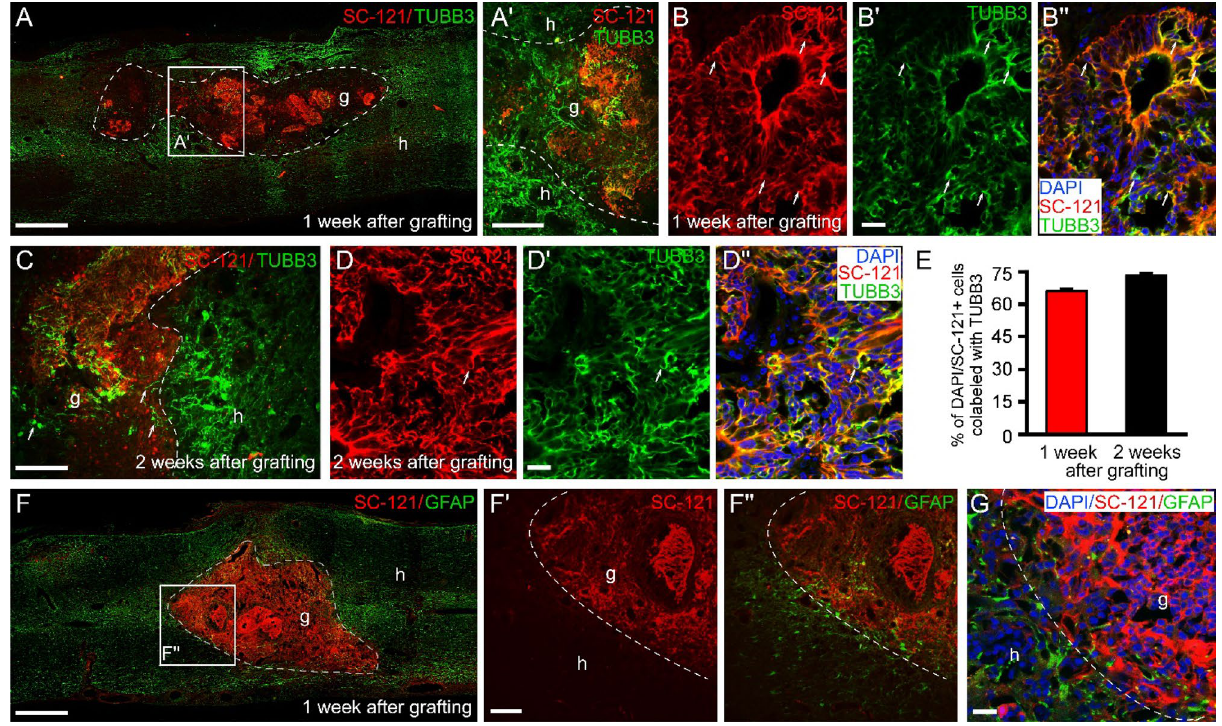
Figure 6. Neuronal differentiation of the intraspinally grafted hiPSCs in the injured rat spinal cord 1 and 2 weeks after transplantation. ( A , A ′ ) Differentiation of intraspinally grafted hiPSCs in the contusion cavity 1 week after grafting leads to the appearance of stem cell-derived neuronal populations in the graft. Host neurites around the lesion site were localized within or very close to the graft. ( A ′ ) Boxed area taken from the graft region shows the mixture of neurites of both host and graft origin. ( B – B ′′ ) Confocal images demonstrate differentiation of hiPSCs (red) along a neuronal lineage identified by TUBB3 (green) expression. ( C ) Notable TUBB3 (green) immunoreactivity was observed within the graft 2 weeks after grafting. ( D – D ′′ ) Colocalization of hiPSCs (red) cells with TUBB3 protein (green) 2 weeks after transplantation. ( E ) Our quantitative analysis 1 and 2 weeks after transplantation showed that the grafted cells mainly expressed TUBB3 (66.1% ± 6.7 and 73.3% ± 5.5, one and two weeks after grafting, respectively; n = 4 in each time point). ( F – F ′′ ) The grafted hiPSCs did not show any GFAP immunoreactivity 1 week after grafting. GFAP-positive immunoreactivity can be seen among the GFAP negative transplanted cells close to the host—graft interface. ( G ) Higher magnification clearly shows presence GFAP-positive processes among the grafted hiPSCs. Dashed line indicates the graft-host border. In A – B ′′ and D – D ′′ arrows show SC-121-positive grafted cells (red) that were colocalized with TUBB3 (green) and TUBB3 + host-derived neurites in ( C ). Data are expressed as mean ± SEM. (n = 4 in each group) g, graft, h, host; Scale bars: ( A ): 500 µm, ( A ′ ): 250 µm, ( B ′ ): 25 µm, ( C ) 250 µm, ( D ′ ): 25 µm, ( F ) 500 µm, ( F ′ ) 100 µm; ( G ) 10